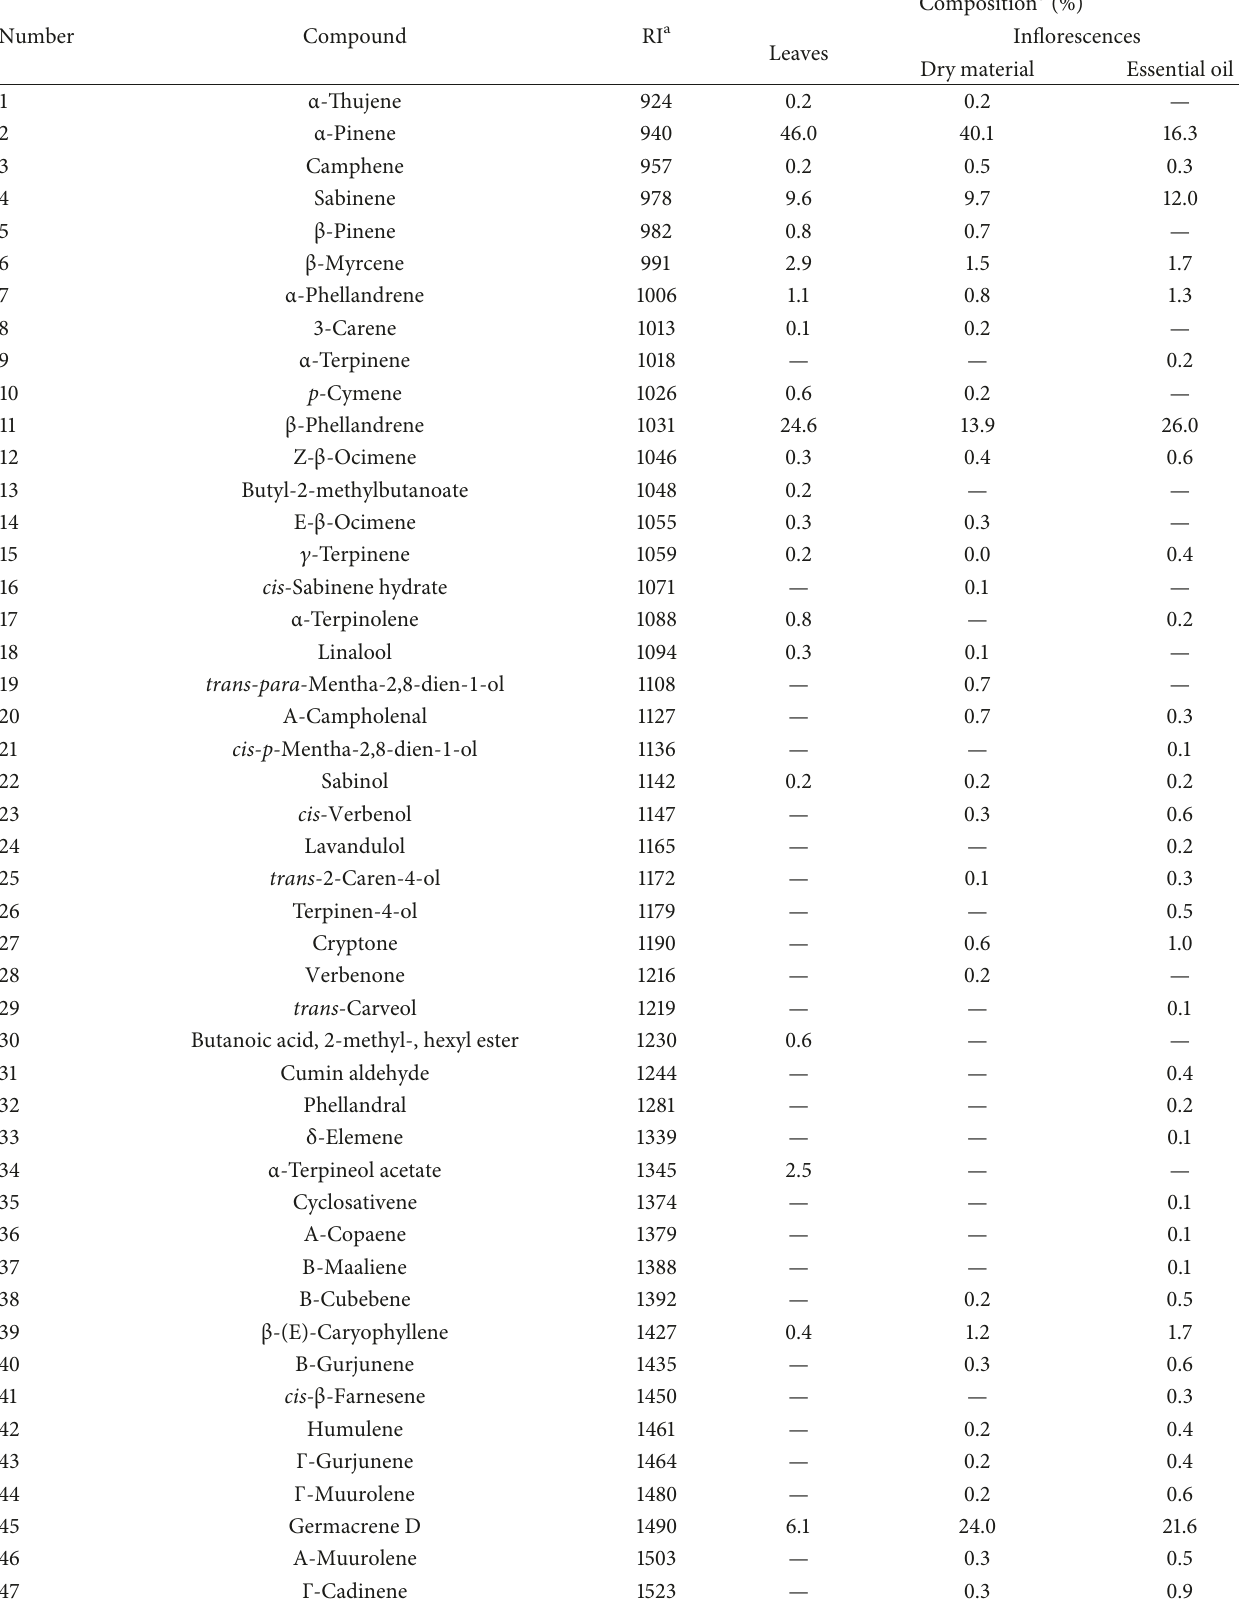
Table 1: Compounds identified by GC-MS technique in the Rudbeckia triloba